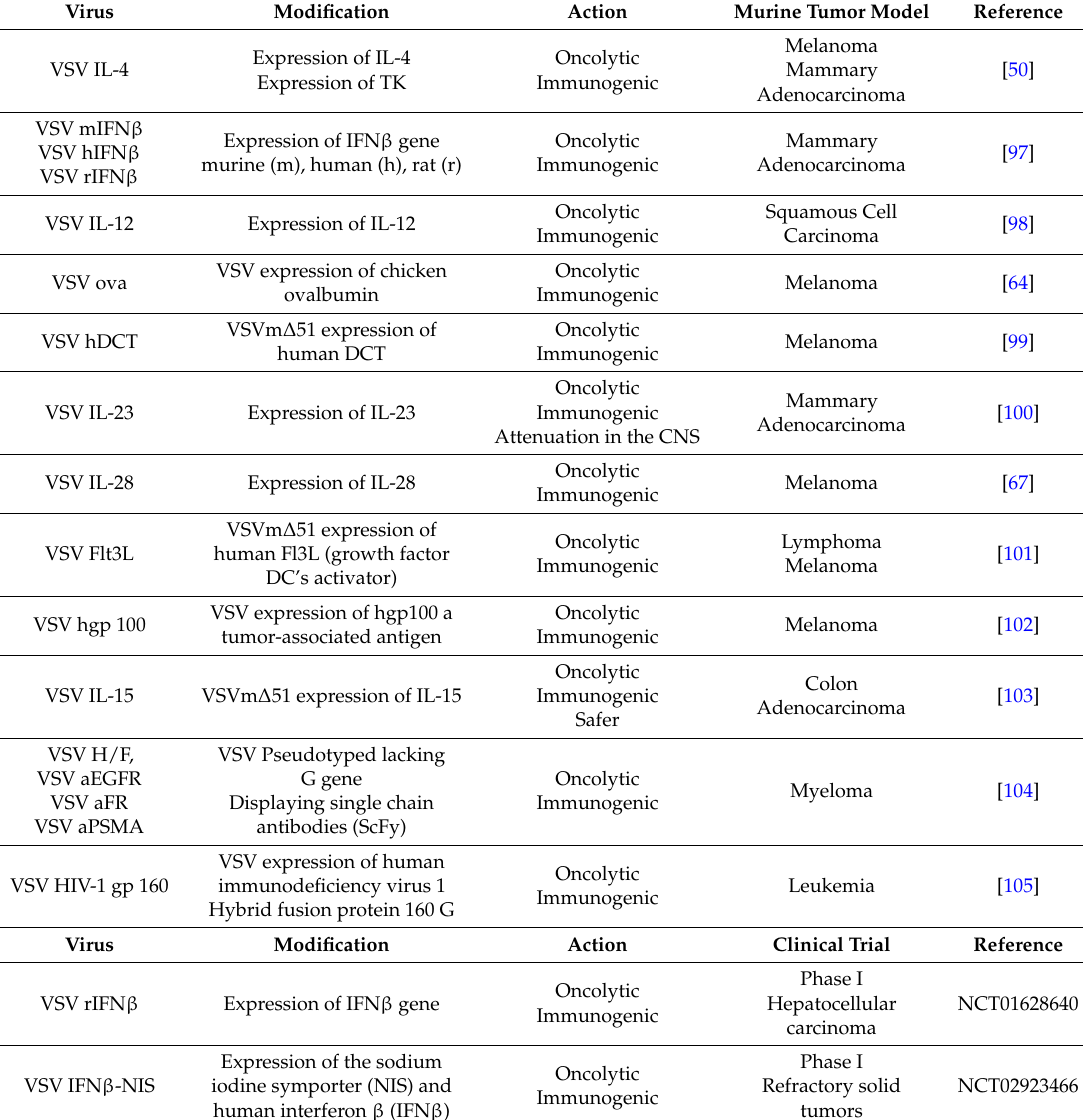
Table 1. Preclinical and clinical recombinant vesicular stomatitis virus (VSV)